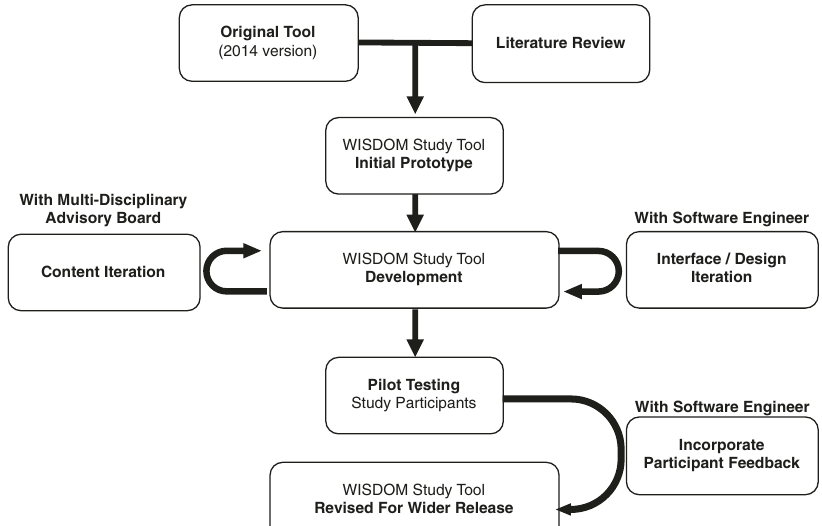
Fig. 4 Development and pilot process for the WISDOM study risk assessment tool. Schematic describing the development and pilot process, which began with a review of the literature and the 2014 version of the tool. The content was developed with a multidisciplinary advisory board. Interface and design were iterated with a software engineer, following feedback from the advisory board and study